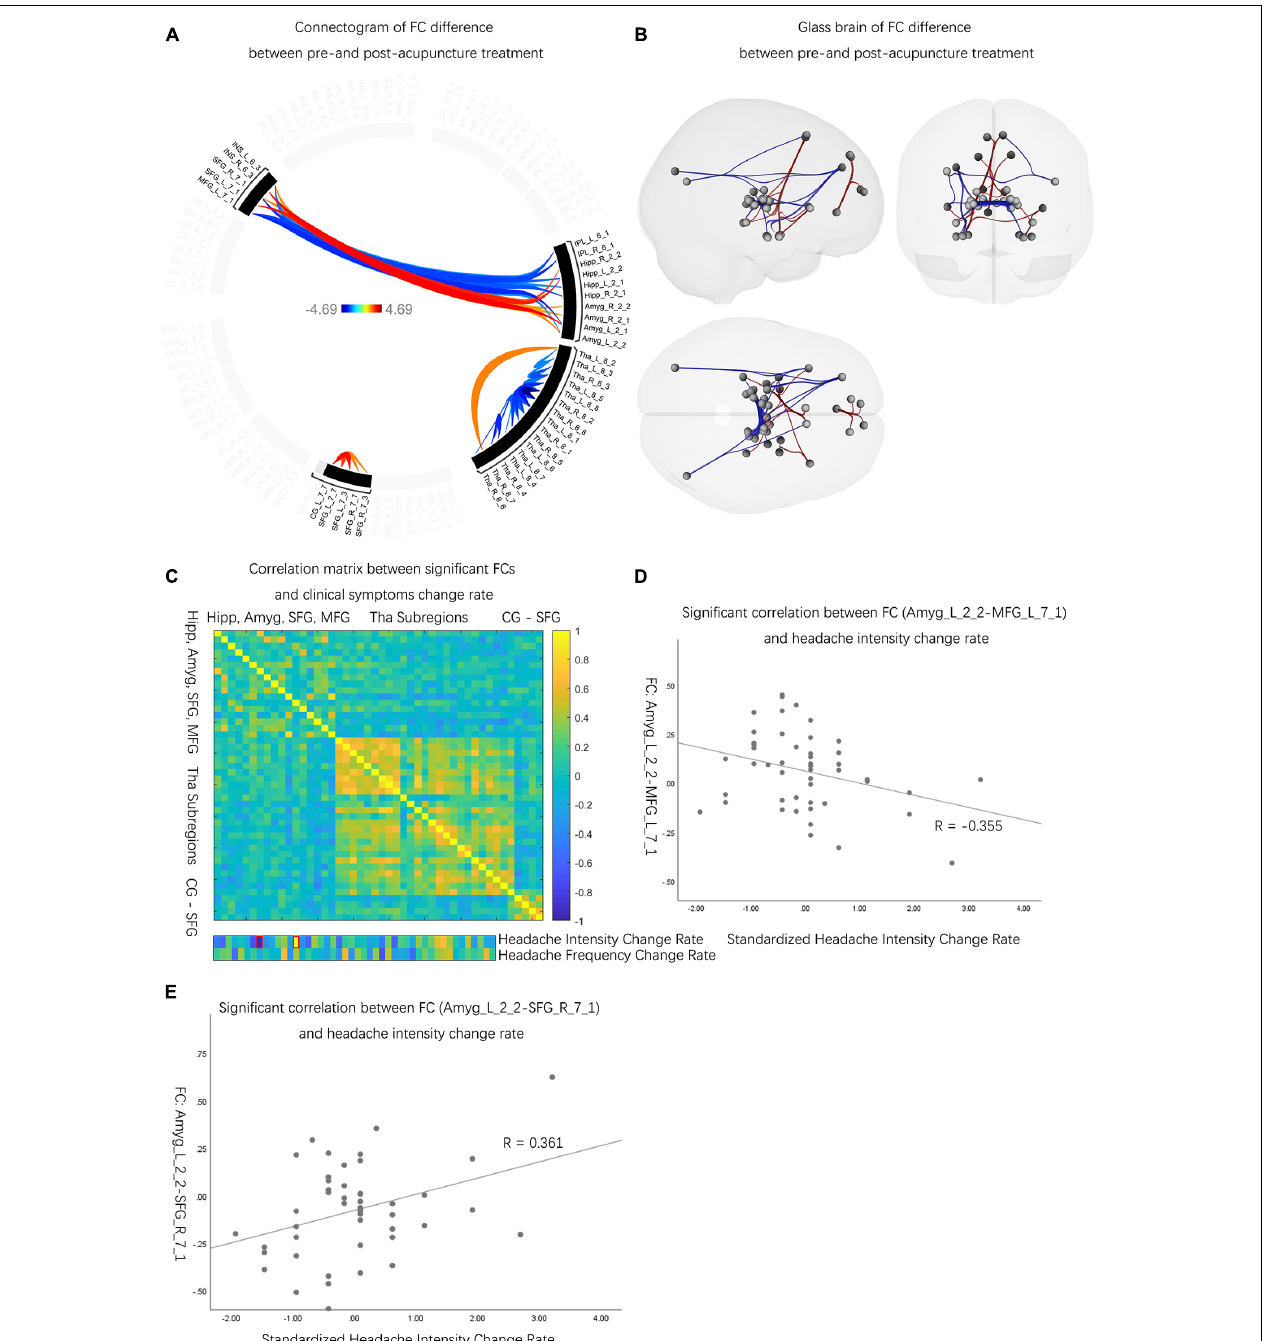
FIGURE 3 | The neuro activities difference before and after acupuncture treatment. (A) Patients with MwoA showed significantly decreased and increased FCs between pre- and post-acupuncture, and the color bar represents the t -value of FC. (B) Compared with pre-acupuncture, patients with MwoA had decreased FCs between Amyg and INS, Amyg and SFG, CG and SFG, Hipp and SFG, and Tha subregions. Also, patients with MwoA had increased FCs between Amyg and MFG, Hipp and MFG, Hipp and INS, IPL and INS, IPL and MFG, IPL and SFG, and within Tha subregions compared with pre-acupuncture. Red connection lines represent an increased FC before acupuncture than post-acupuncture patients with MwoA, and blue lines vice versa . (C) Two FCs were significantly correlated with change rate of headache intensity, with the red rectangle circling the significantly correlated FCs. The color bar represents the Pearson correlation coefficient, and the closer the absolute value is to 1, the higher the correlation is, and vice versa . (D) The FC between the left Amyg and the left MFG was significantly correlated with headache intensity change rate ( r = –0.355, p < 0.05). (E) The FC between the left Amyg and the right SFG correlated with headache intensity change rate ( r = 0.361, p < 0.05). MwoA, migraine without aura; FC, functional connectivity; L, left hemisphere; R, right hemisphere; SFG, superior frontal gyrus; MFG, middle frontal gyrus; SPL, superior parietal lobule; IPL, inferior parietal lobule; INS, insular gyrus; CG, cingulate gyrus; Amyg, amygdala; Hipp, hippocampus; Tha,